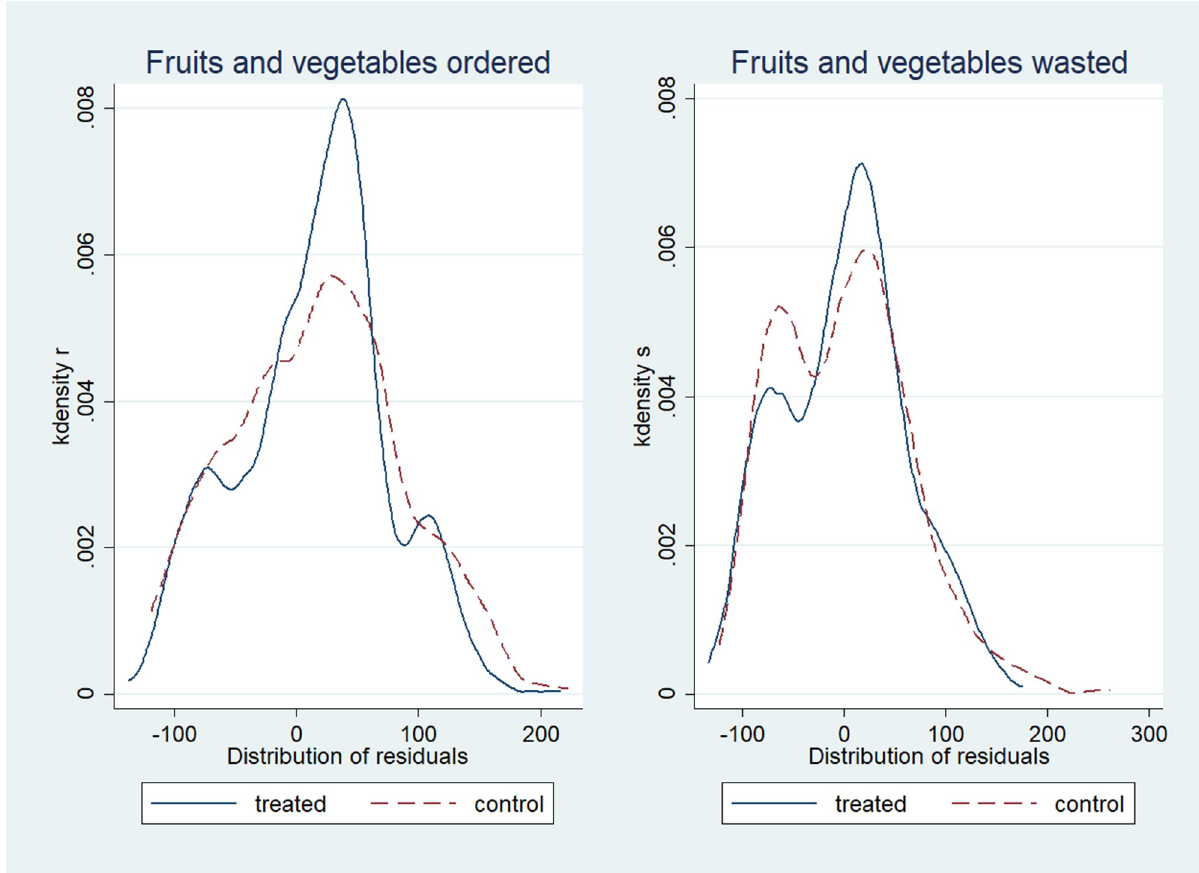
Fig 3. Distribution of residuals from the estimation results for Eq